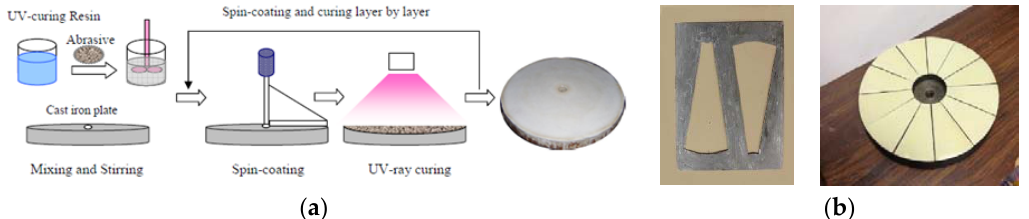
Figure 3. Schematic diagram of the curing processes of the ultraviolet-curable resin bond abrasive tool through ( a ) spin-coating method; and ( b ) fan-shaped pieces assembly method.